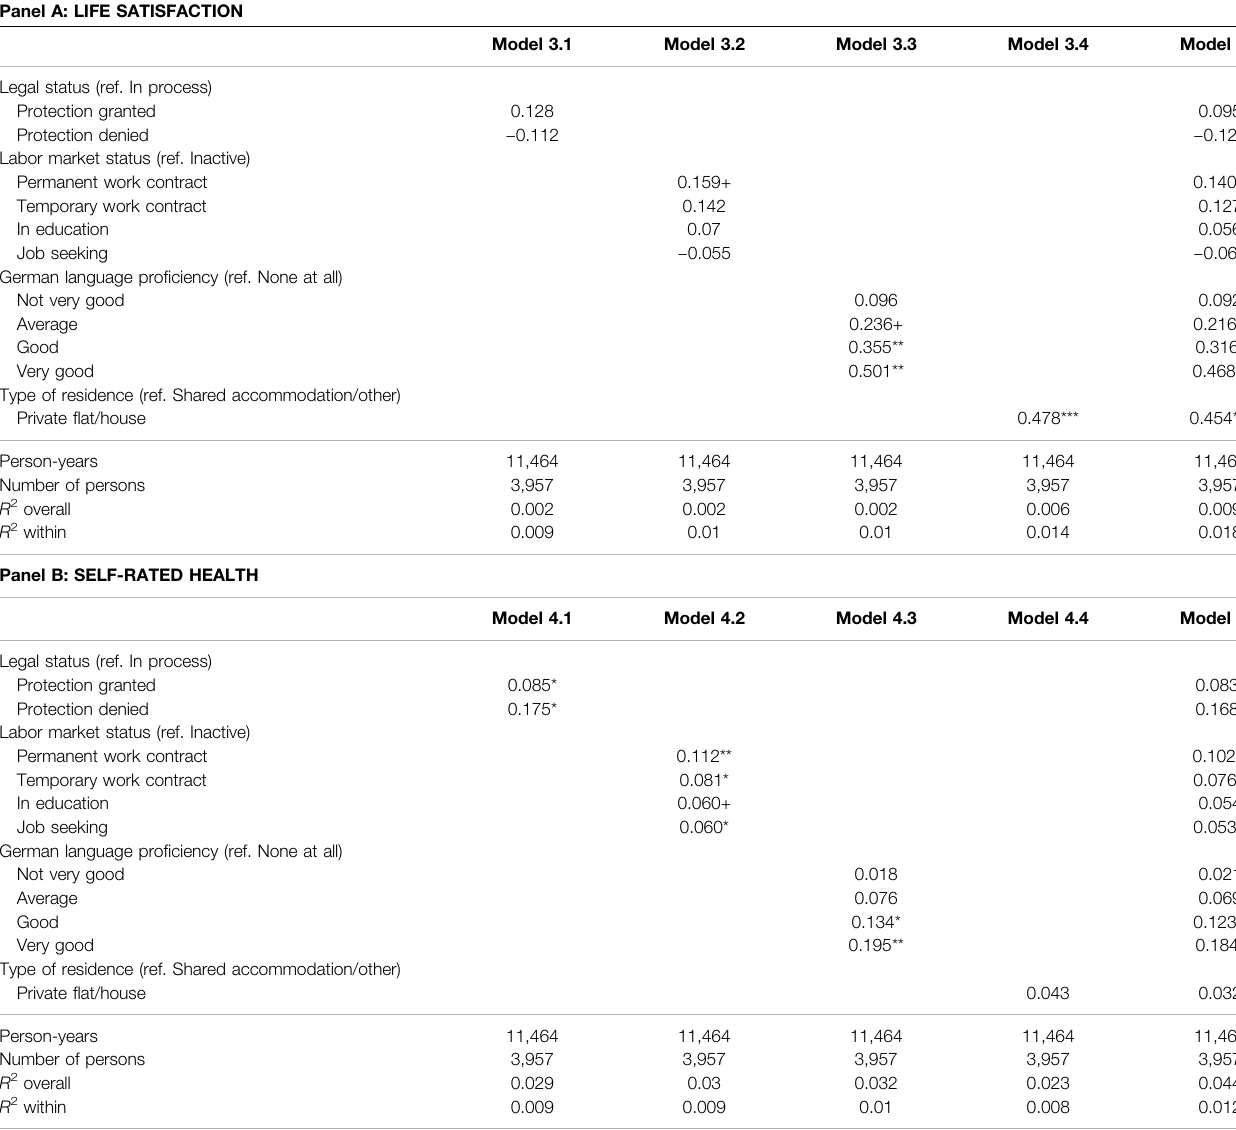
TABLE 3 | Associations between postarrival experiences and life satisfaction and self-rated health. Panel A: LIFE